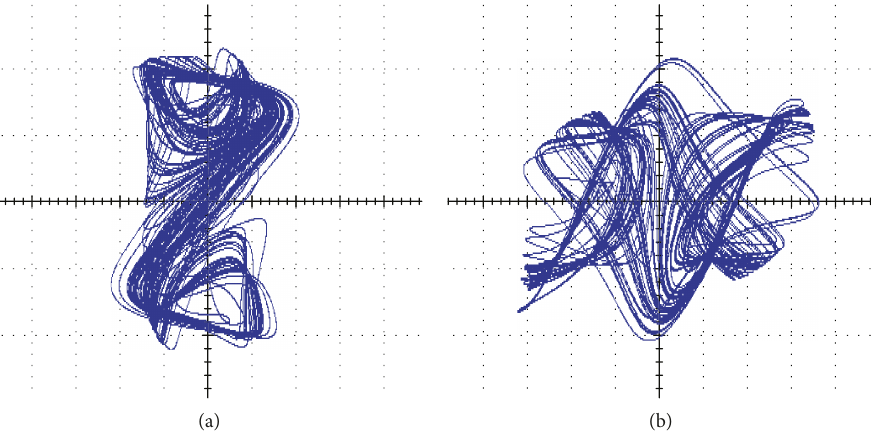
Figure 12: Circuit implementation of the double-scroll hyperchaotic system. (a) y , w plane. (b) x , y